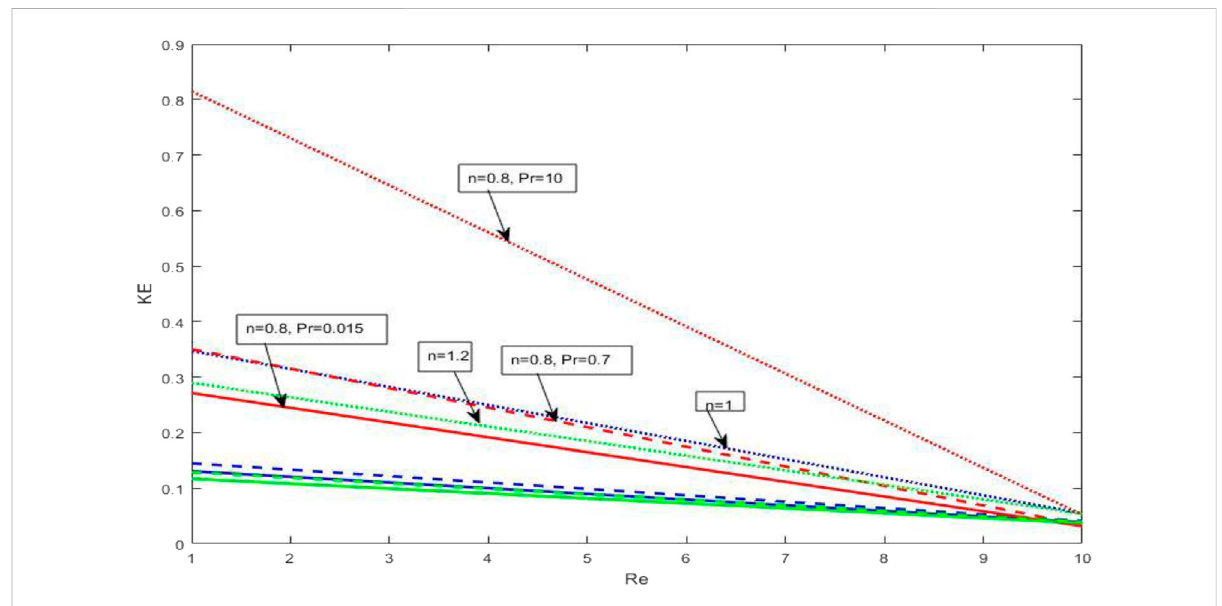
FIGURE 19 Variation in the kinetic energy ( K . E ) against the Reynolds number ( Re )